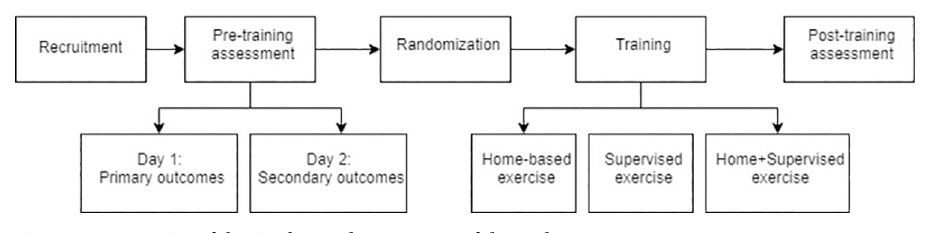
Fig 2. Representation of the timeline and assessments of the